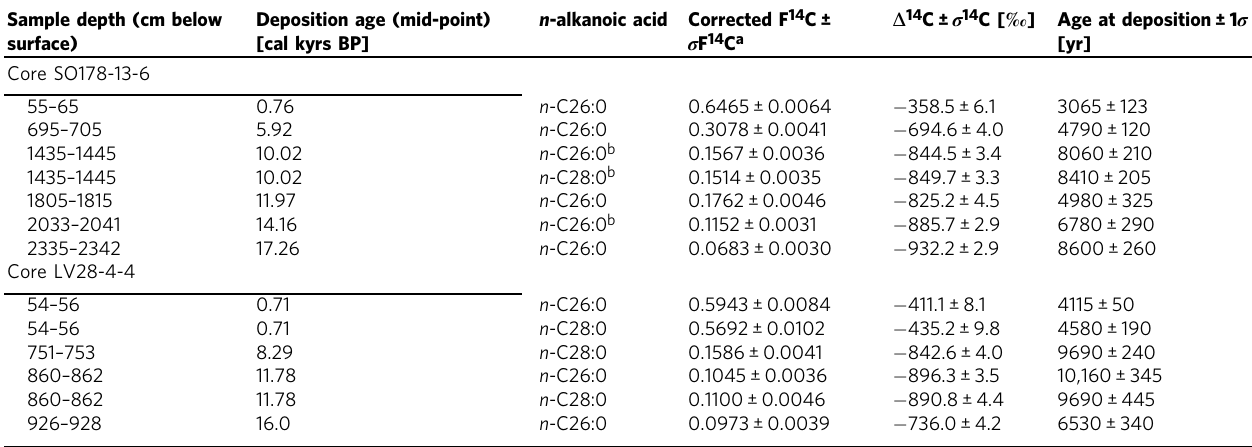
a Corrected for blank contribution and methylation; ±propagated error (see Methods) b 66% split of sample